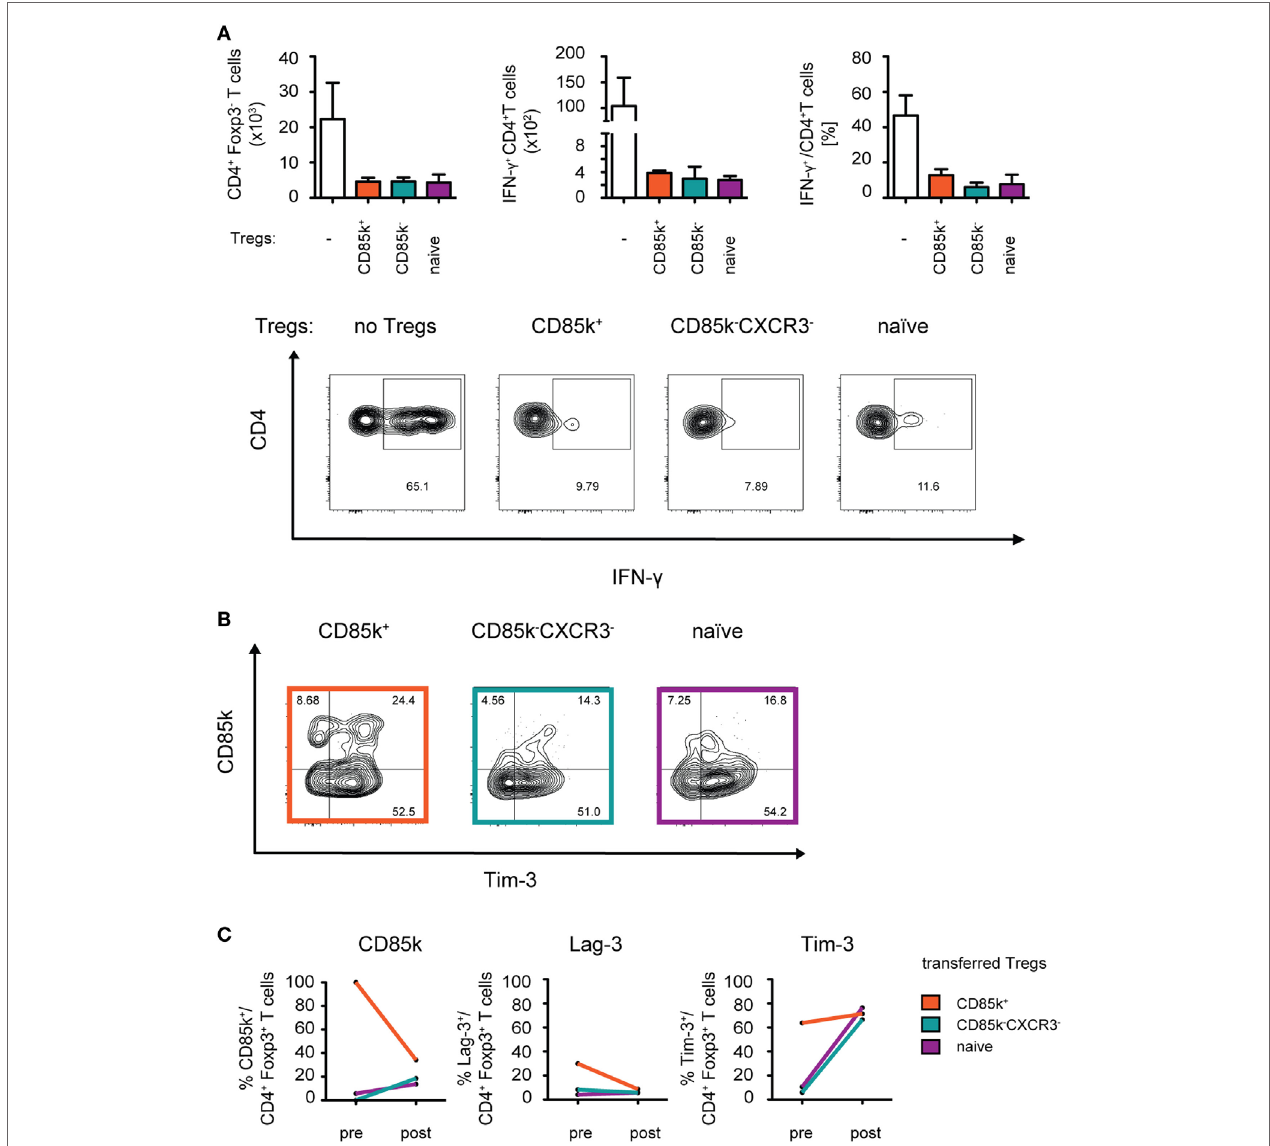
FigUre 6 | CD85k + Treg cells display dynamic expression of co-inhibitory receptors in vivo . Rag1 − / − mice were reconstituted i.v. with 5 × 10 5 CD8 + and 5 × 10 5 CD4 + Foxp3-GFP − effector T cells together with 10 5 naïve, CD85k + , or CXCR3 − CD85k − Treg cells sorted from naïve or LCMV-infected (days 12–14) Foxp3 -GFP KI reporter mice, respectively. (a) 10 days post transfer, total numbers of splenic CD4 + Foxp3 − effector T cells were determined and IFN- γ production upon restimulation with PMA/Ionomycin was measured by flow cytometry. (B,c) In the same samples as in (a) , expression of co-inhibitory receptors in CD4 + Foxp3 + Treg cells was analyzed and (c) compared to initial levels of the markers within the specific Treg subset prior to transfer. Data in summary graphs (a) are displayed as mean ± SD, n = 2–4 (pooled data from two independent experiments). (c) mean value of pre = 5 biological replicates and post = 4 biological